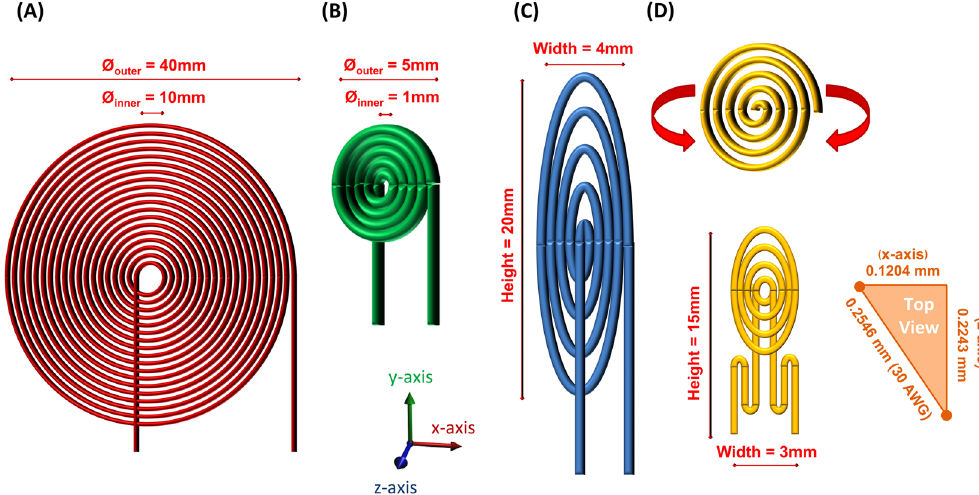
Figure 2. Antenna Design. ( A ) The transmitter coil was designed as a planar spiral coil with a 10 mm inner diameter, 40 mm outer diameter, 23 AWG wire, and 18 turns of the coil. ( B ) Receiver coil designed with 4 turns of 30 AWG wire with a circular geometry and no spacing between each turn resulting in a 5 mm outer diameter. ( C ) Receiver coil designed with 4 turns of 30 AWG wire with elliptical geometry without spacing between coils in the x-direction, resulting in a width of 4 mm, and over 2 mm of spacing between the coils in the y-direction, leading to a height of 20 mm, and ( D ) Receiver coil designed with 4 circular turns and 3 meandering turns of a 30 AWG wire. The upper figure highlights a coil with a circular geometry and spacing between coils equal to that of the wire diameter. This configuration wraps into the z-direction along the y-axis of the coil and forms into a half-cylindrical shape. This design was further supplemented by a meandering structure, resulting in a final antenna shape shown at the bottom-left with width of 3 mm, height of 15 mm, and depth of 2 mm. The lower right diagram demonstrates > 50% space reduction along the x-direction through the transfer of coil spacing into the